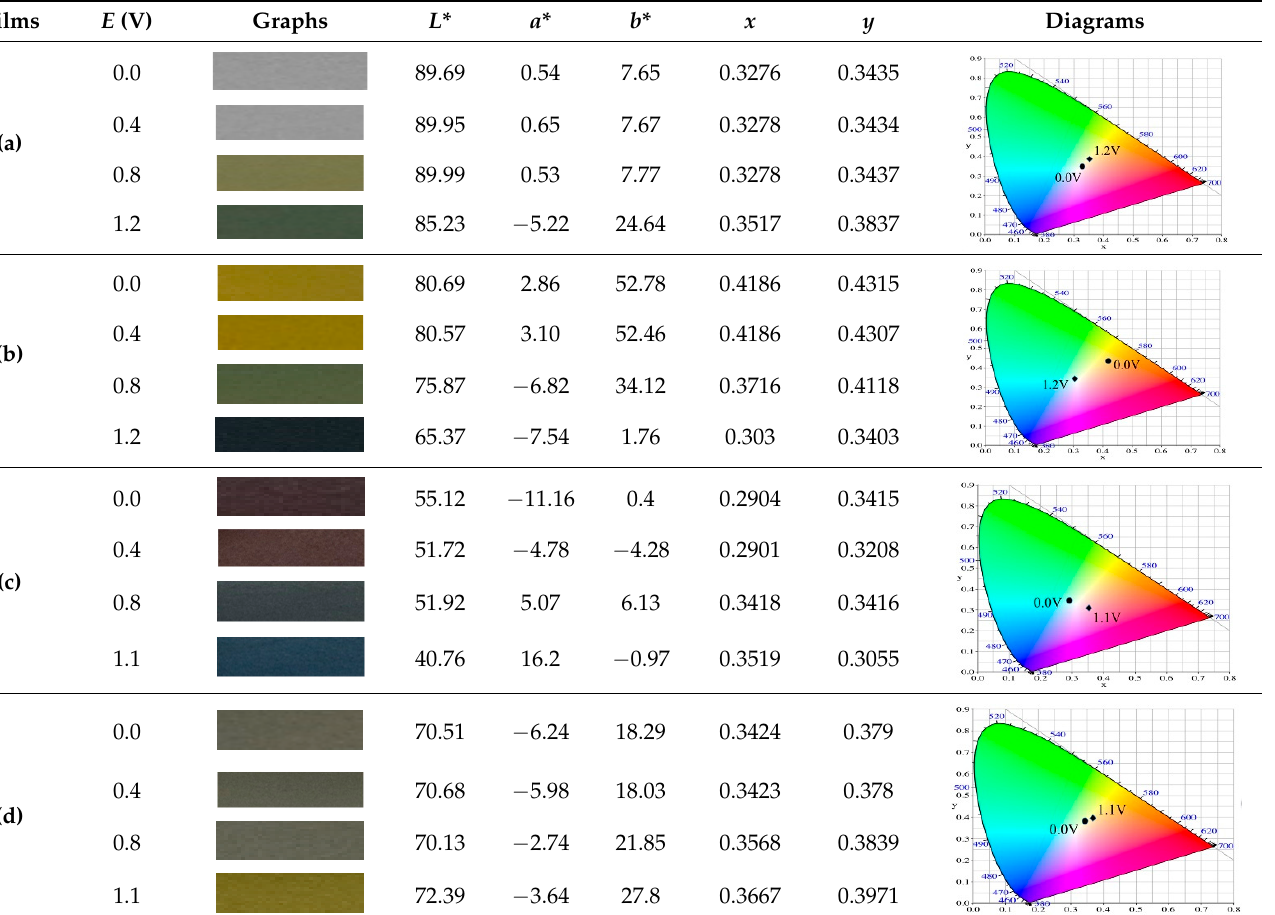
Table 2. Colorimetric values ( L *, a *, and b *), CIE chromaticity values ( x , y ), and diagrams of ( a ) PBPBC, ( b ) P(BPBC- co -BT), ( c ) P(BPBC- co -CDT), and ( d ) P(BPBC- co -CDTK) at several potentials.